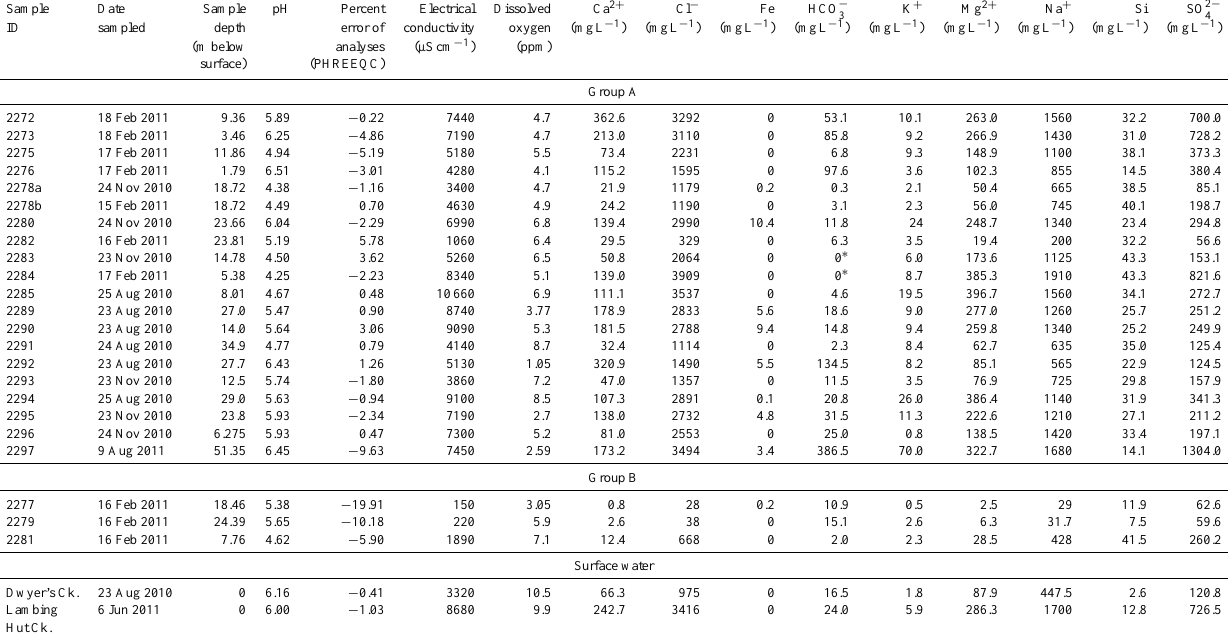
Table 1. Groundwater and surface water sampling details, field parameters and major ion compositions.